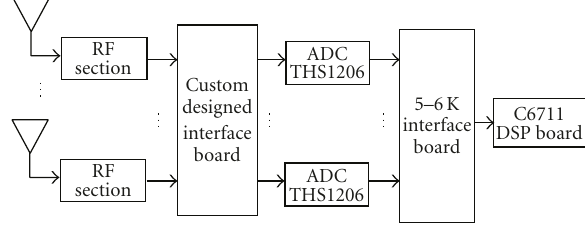
Figure 1: Block diagram of UKM testbed receiver.